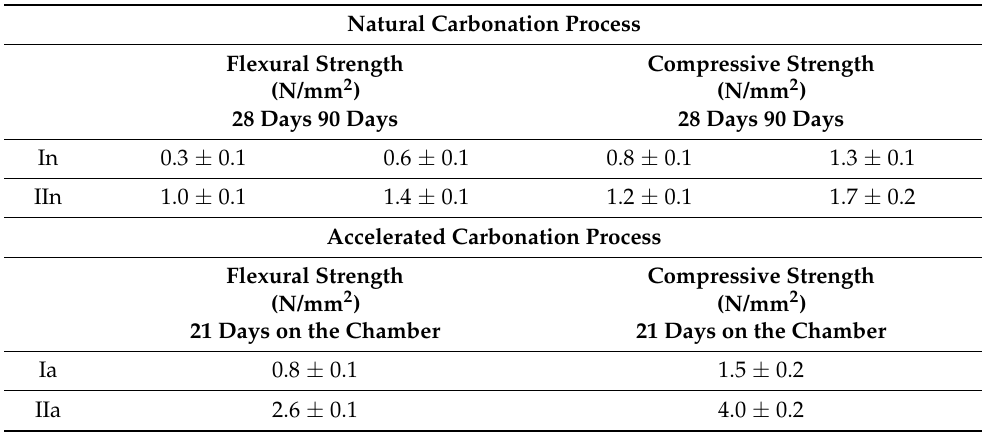
Table 9. Values of the flexion and compression tests for both groups of specimens Group I and Group II. The averages obtained for the specimens taken on the different test days for the different groups of specimens Group I and Group II are